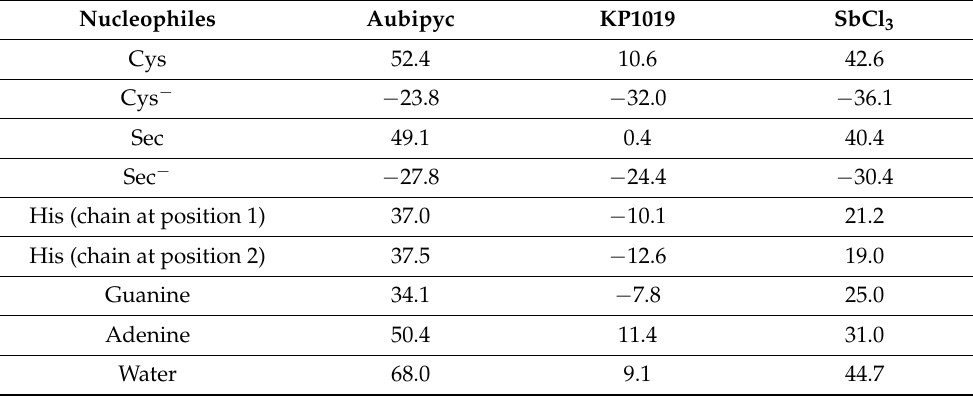
Table 2. Gibbs free energies for the binding of the selected metallodrugs at possible target nucleophile sites in SARS-CoV-2 proteins or nucleobase strands via the substitution of a chloride ligand. All values are reported in